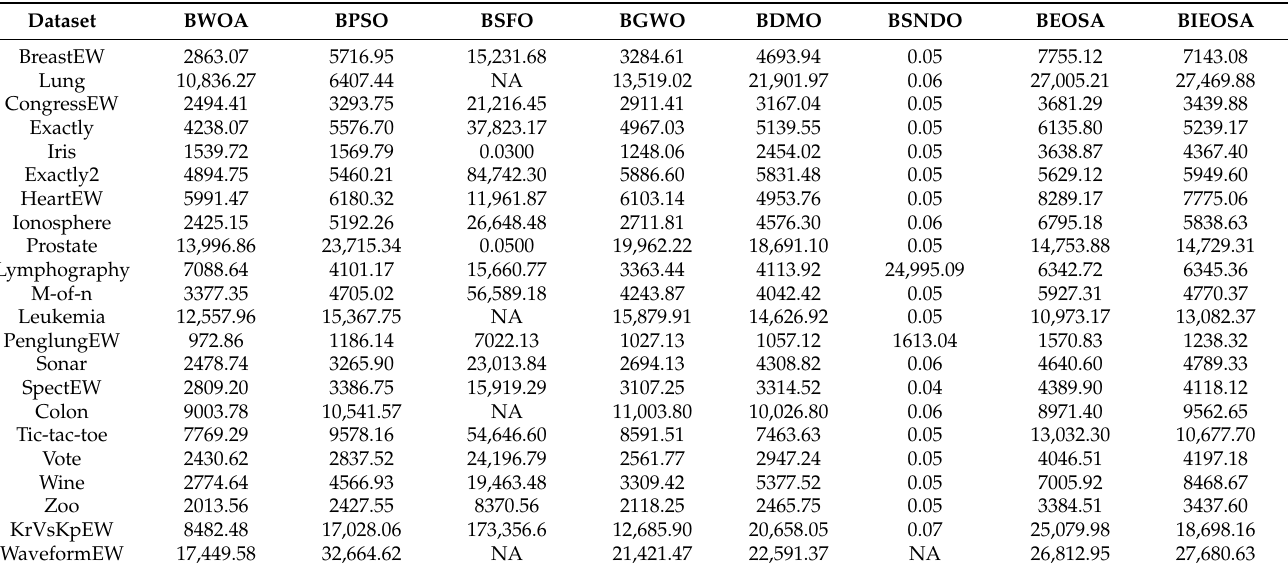
Table 7. Comparative analysis of the computational times of BWOA, BPSO, BSFO, BGWO, BDMO, BSNDO, BEOSA, and